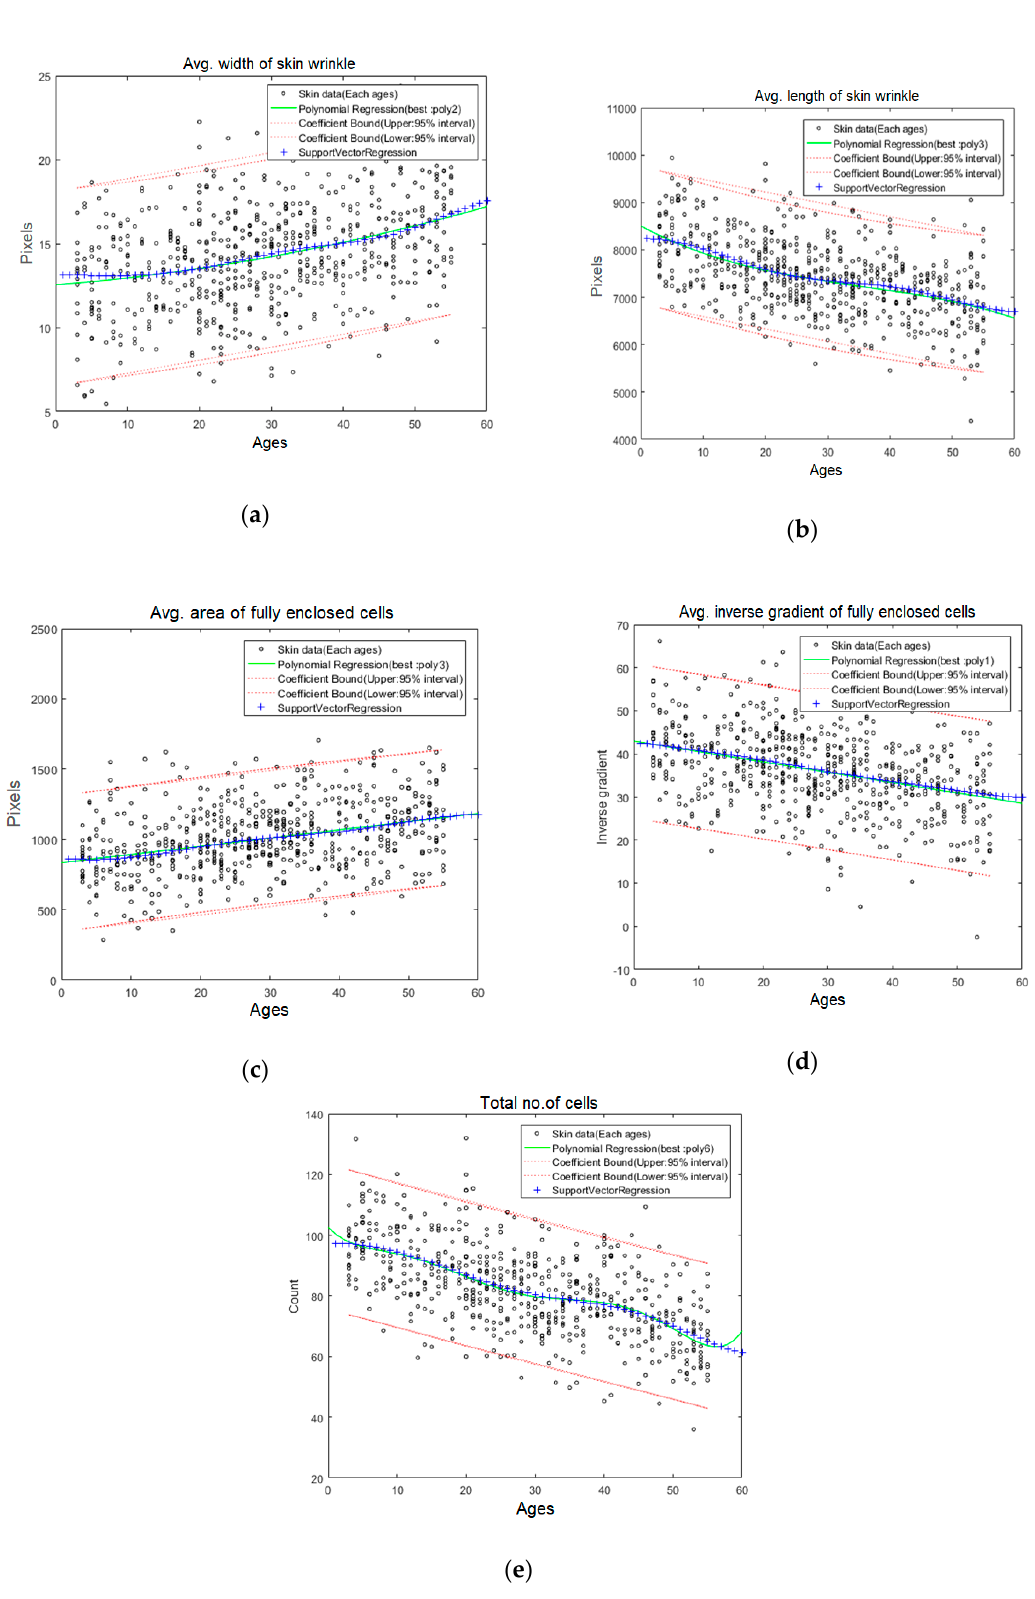
Figure 12. Face skin texture aging trend estimation using polynomial regression and SVR—( a ) average width trend of face wrinkle; ( b ) average length trend of face wrinkle; ( c ) average area trend of fully enclosed face cells; ( d ) average inverse gradient trend of fully enclosed face cells; (e) trend of the total number of face cells.